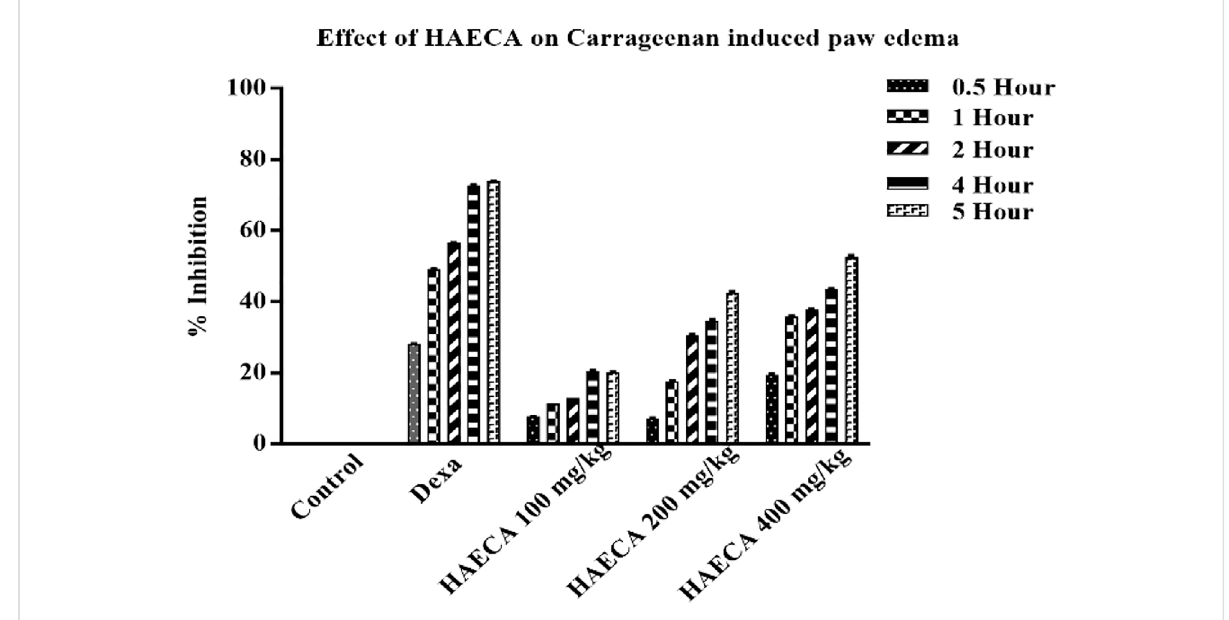
FIGURE 8 Percent inhibition of carrageenan-induced paw edema by